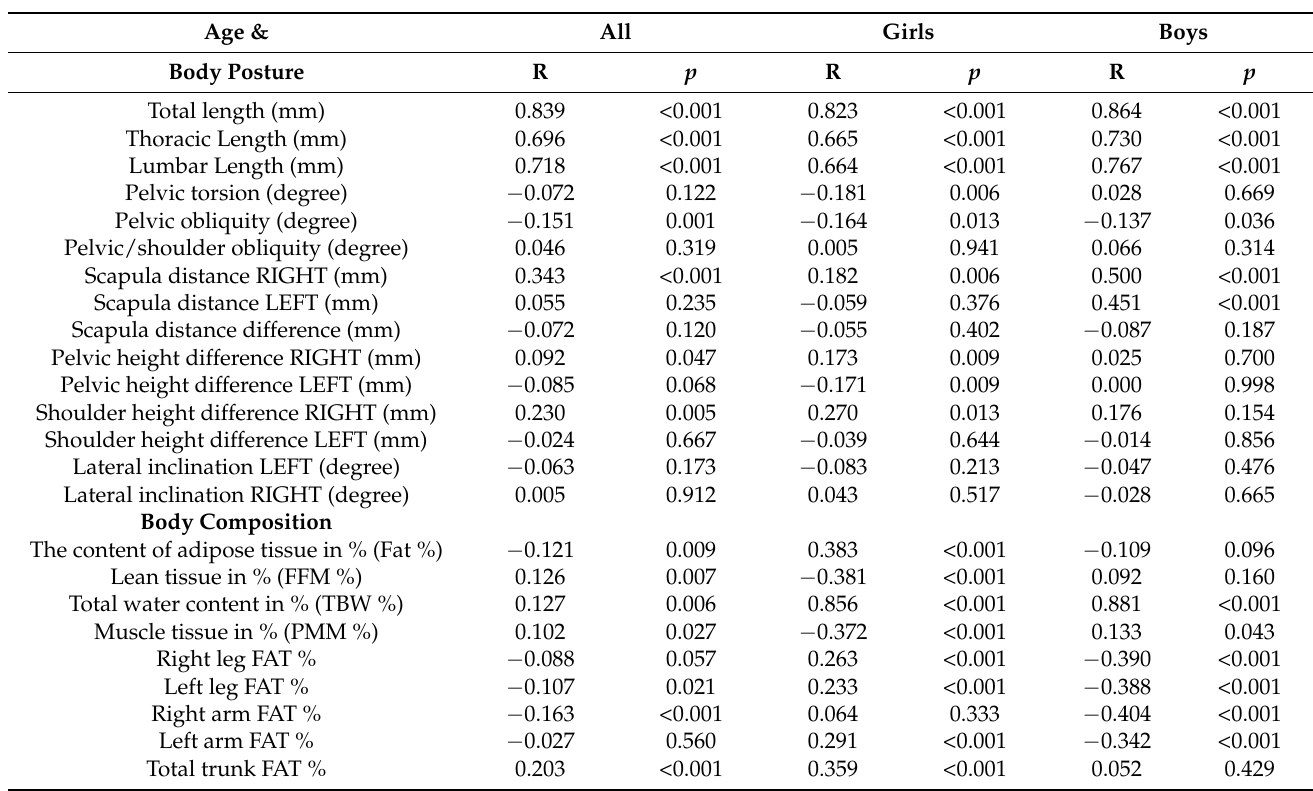
Table 2. Correlation between age and body posture and body composition parameters.